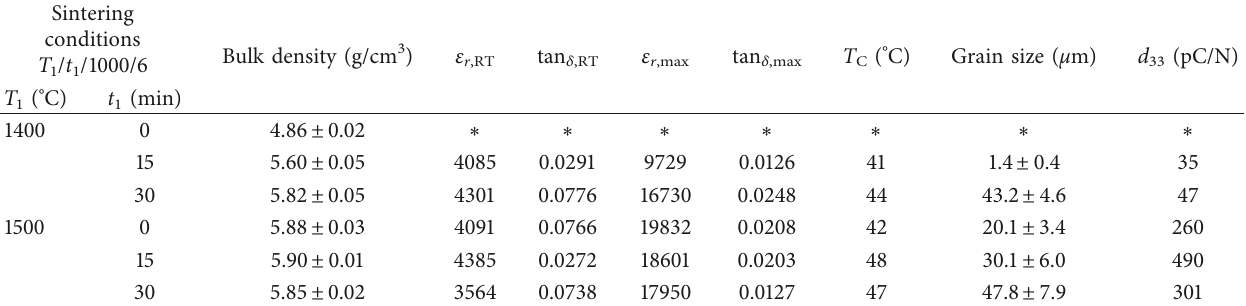
Table 1: The bulk density, ε r , and tan δ at room temperature (RT), ε r ,max and tan δ ,max at Curie temperature ( T C ), and T C at 1kHz, grain size, and piezoelectric coefficient ( d 33 ) of the BTS